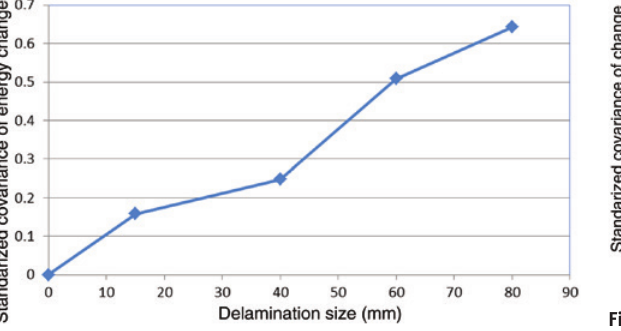
Figure 13: Covariance of energy change at Section 1.